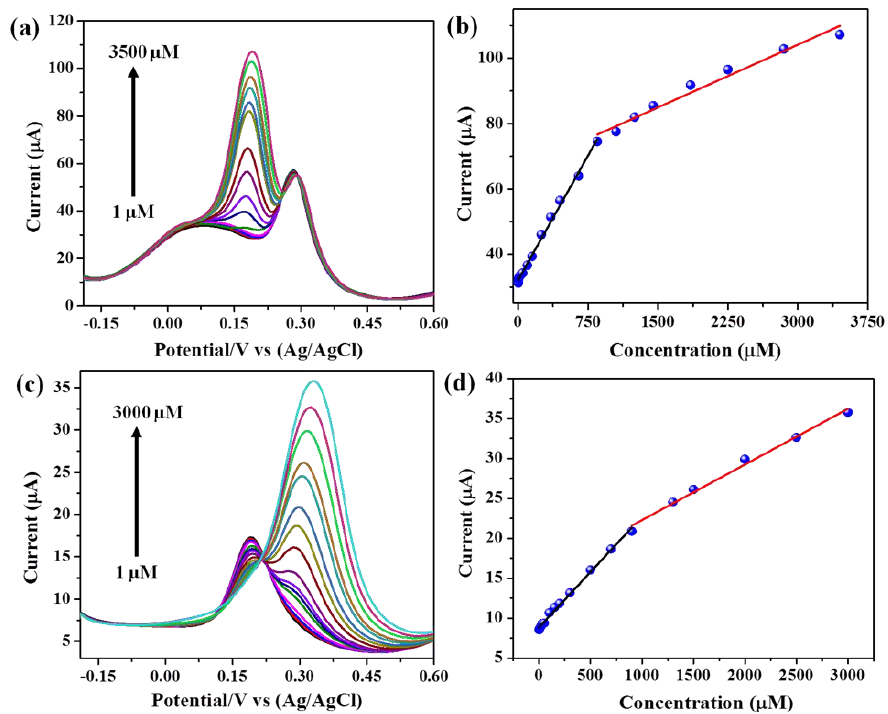
Figure 6. ( a ) DPV curves of CuS CuS-CNF/GCE in 0.1 M PBS (Ph = 5), ( a ) 50 µM of CC and different amount of HQ, ( b ) the current vs. the concentration of HQ, ( c ) 50 µM of HQ and different amount of CC, and ( d ) the current vs. the concentration of CC.